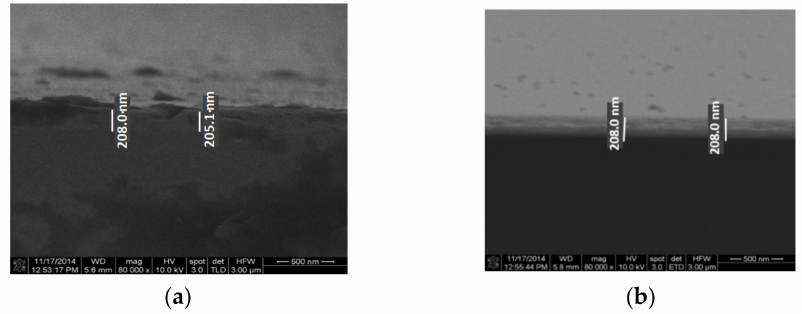
Figure 16. SEM investigations of metal films ( a ) Si/Al; ( b )